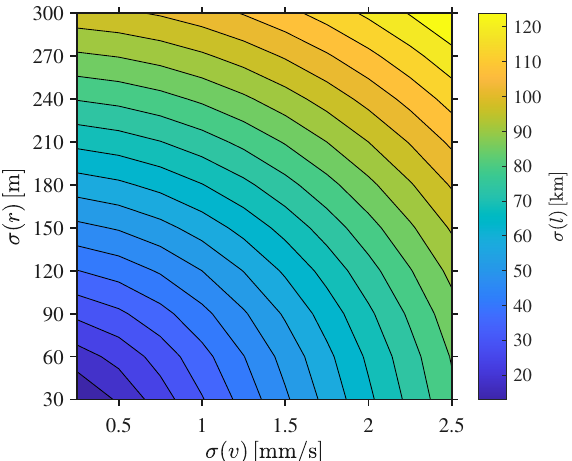
Figure 12. Effects of position and velocity errors on the arm length (three months’ propagation).